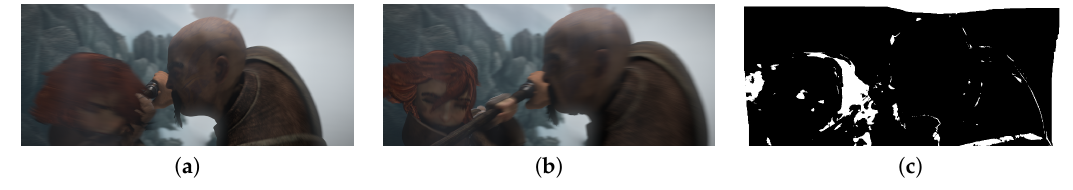
Figure 1. Occlusion estimation comparing optical flow error with a threshold θ occ . ( a ) Frame_0049 of sequence ambush_5; ( b ) Frame_0050; ( c ) occlusion